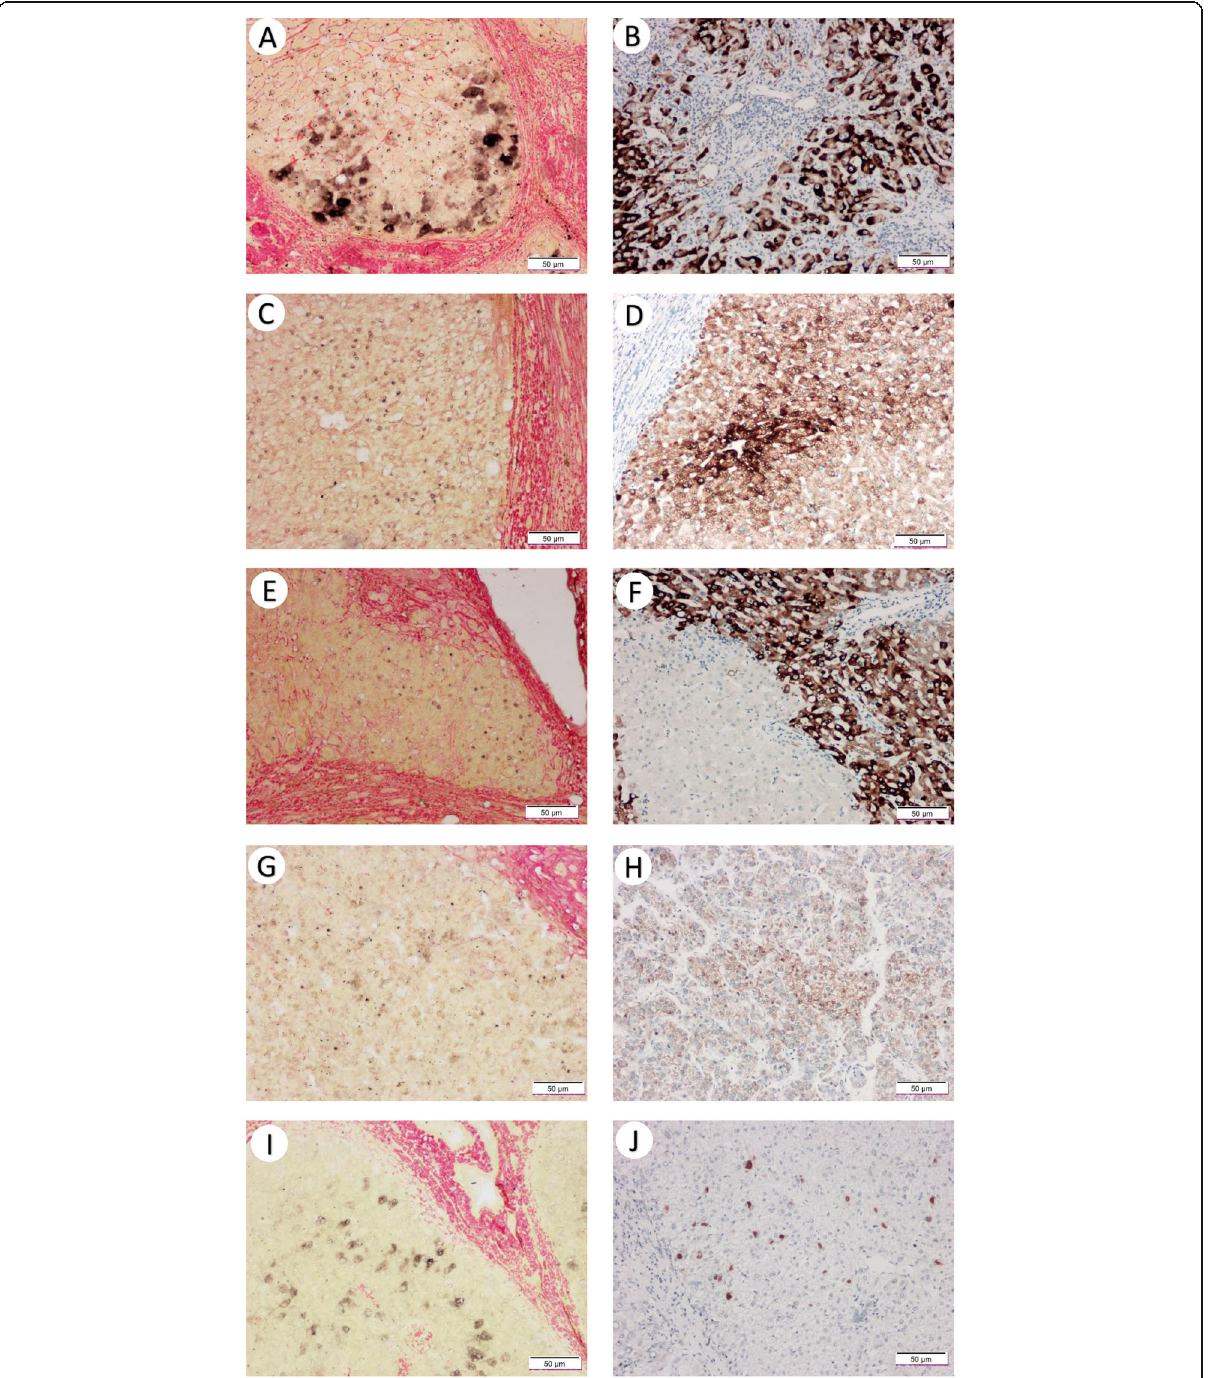
Fig. 2 Typical results of HBV DNA ISH ( A,C,E,G,I ) and HBsAg IHC ( B,D,F,H,J ). (A-B) Intense HBsAg and HBV DNA signal observed in only the tumor- surrounding tissues of a patient. In another two patients (C-F and G-J), HBV DNA and HBsAg can be observed in both surrounding tissue (E-F, I-J) and within tumor (C-D,